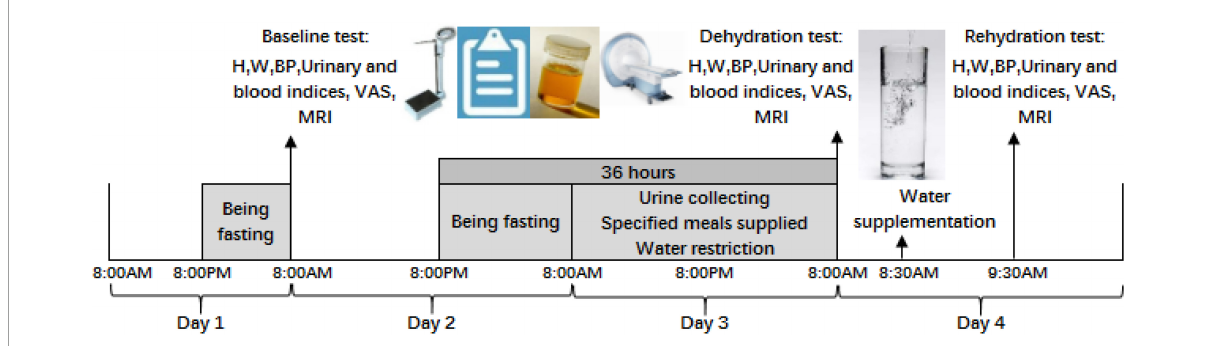
FIGURE1 Procedure of the study. H is the abbreviation for height; W is weight; BP is blood pressure; VAS is visual analog scales; MRI is magnetic resonance